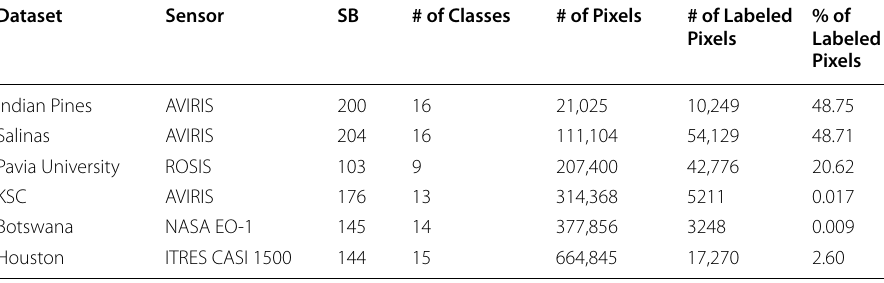
Table 1 Information on the more popular datasets in HSI semantic segmentation used in this paper, SP stands for Spectral Bands [5]